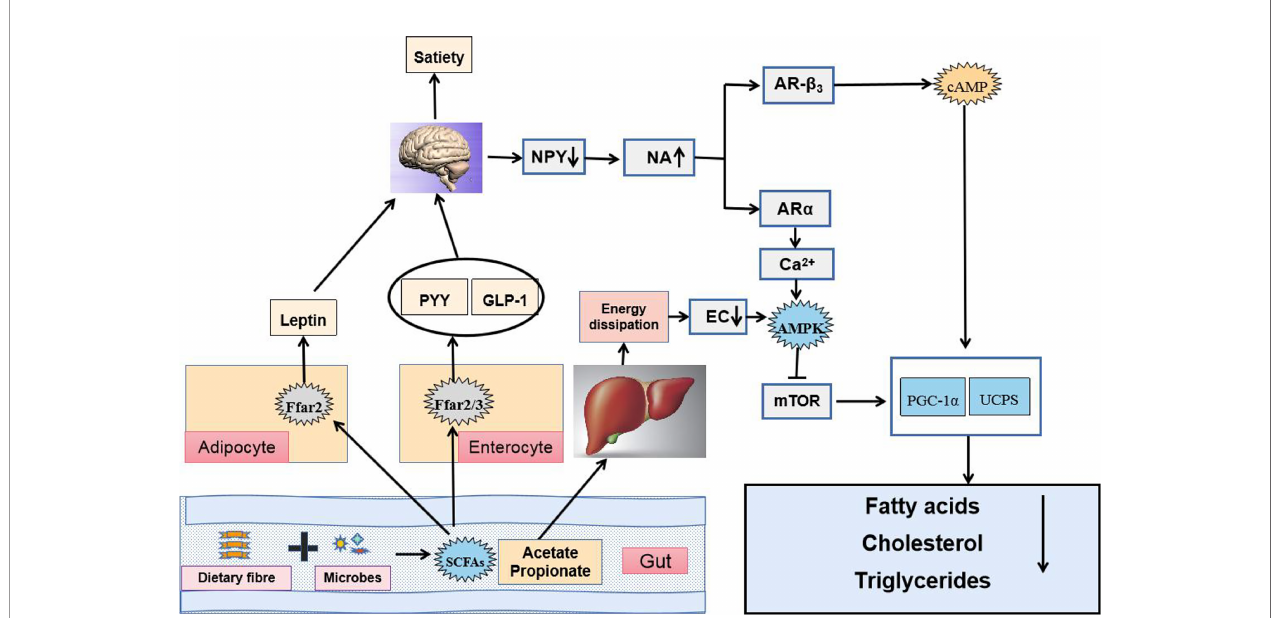
FIGURE 4 | SCFAs regulate energy metabolism through the gut – brain axis and the AMPK pathway to improve